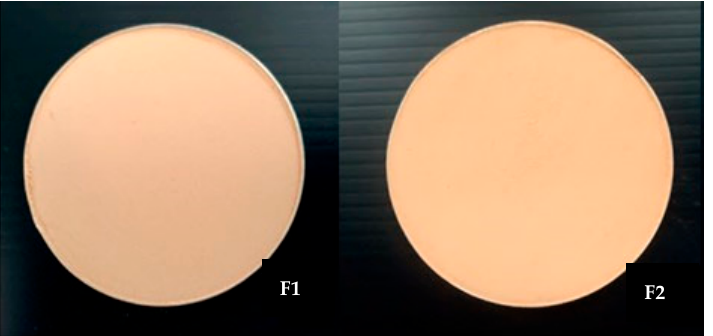
Figure 6. The appearance of the puffs for the breakage test: the talcum-compact powder (F1) and the modified rice flour replaced talcum (F2).